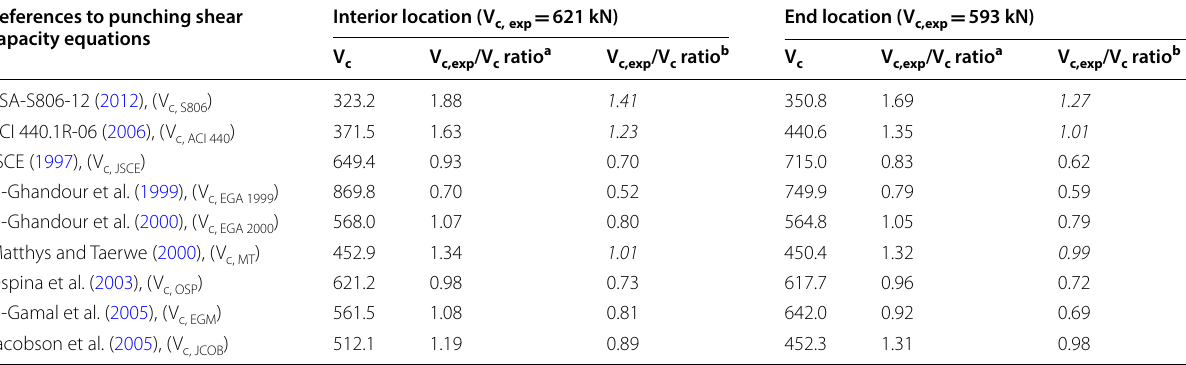
Table 2 Punching shear capacities of the tested GFRP‑reinforced PL‑3 bridge barriers using available design codes and previous